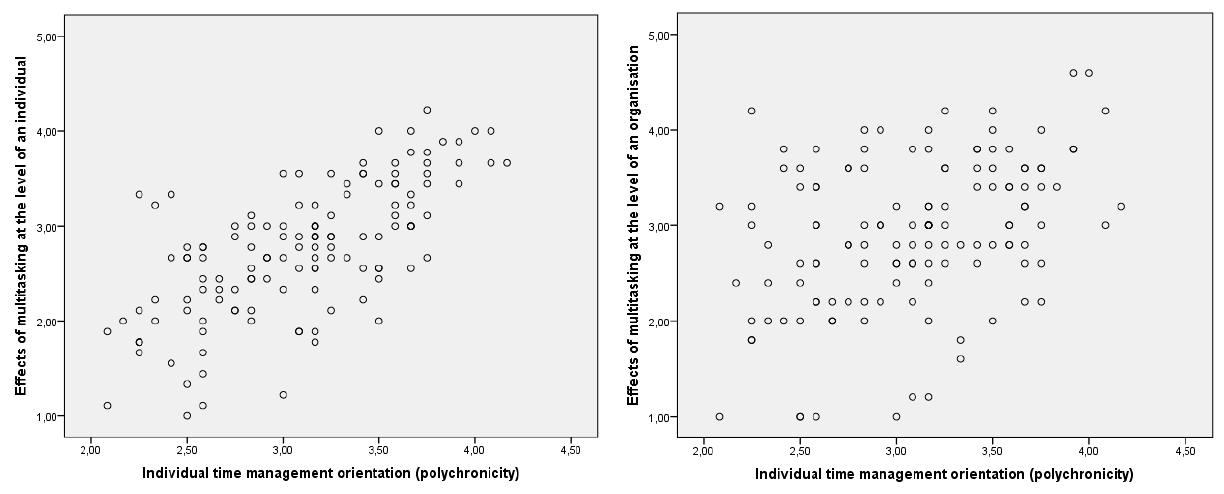
Figure 4. Relationship between TMO (polychronicity) and perception of multitasking